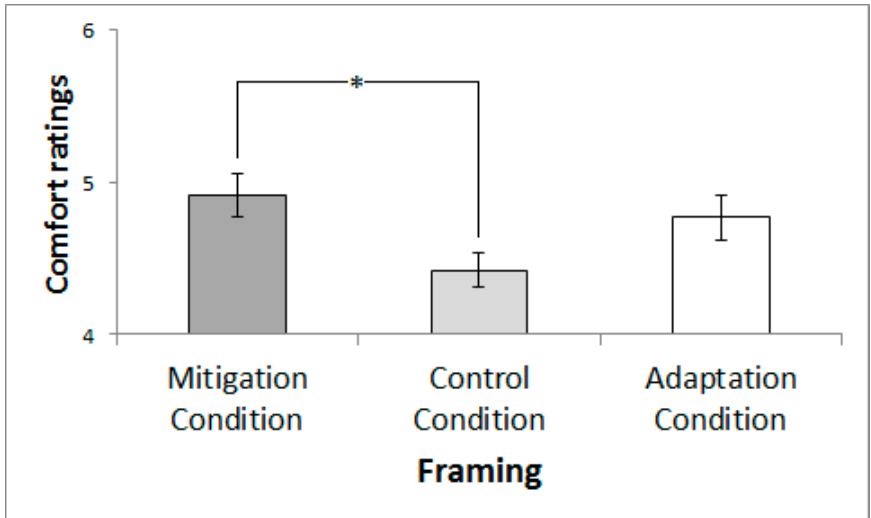
Figure 1. Mean perceived overall comfort ratings assigned to a classroom in a building. The participants were either told that a mitigation intervention or that an adaptation intervention had led to the building being environmentally certified or they were not at all told that the building was environmentally certified. Error bars represent standard error of means. Note: * Significant at alpha = 0.05.